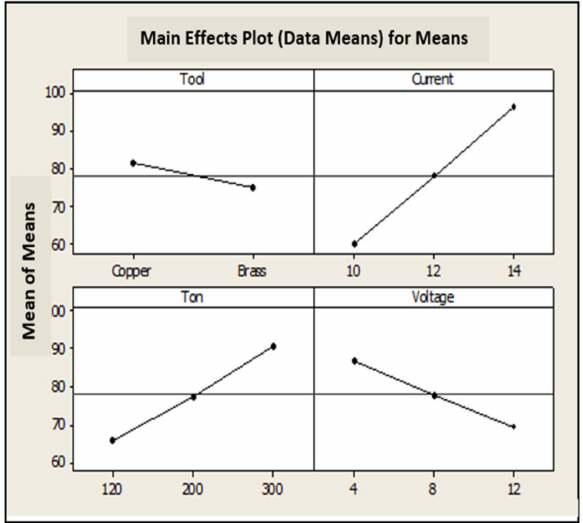
Figure 4. Main effects plots (means) for MRR (mg/min) (units: current (Amp), voltage (V), T on ( µ s)).